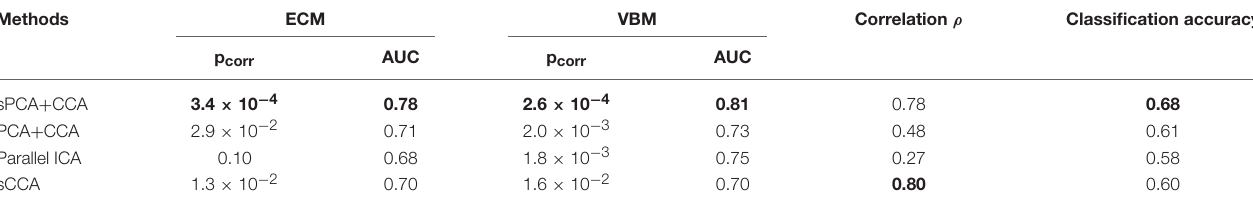
TABLE 1 | Measurements of the modulation profiles in sPCA + CCA, PCA + CCA, parallel ICA and sCCA. Methods